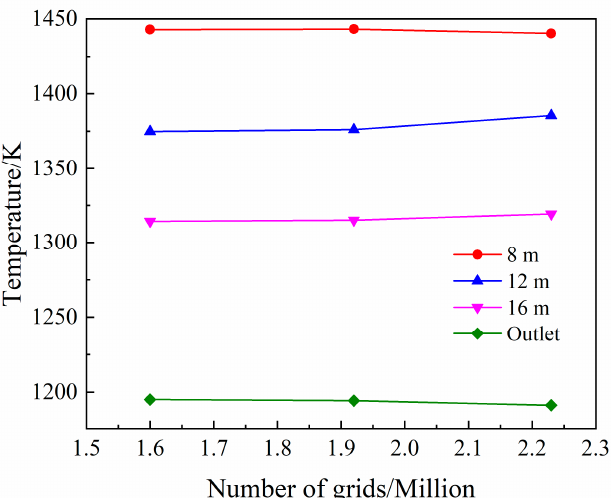
Figure 4. Variation curve of the average temperature of different height sections of the furnace chamber with the number of grids.